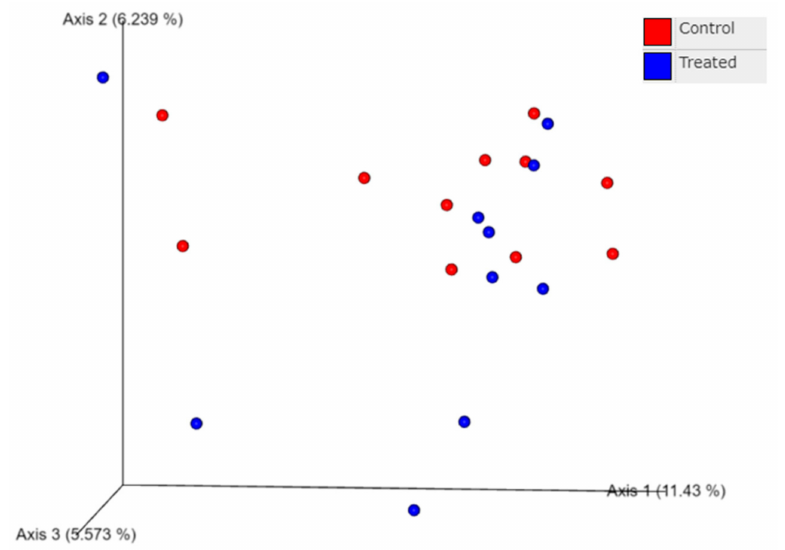
Figure 5. Principal coordinate analysis of unweighted UniFrac distances obtained from nasal swabs of calves at weaning. Data from 11 calves from CTR cows and cows supplemented with Se-yeast boluses (105 mg Se/wk), during the first (TR-1) trimester of gestation, that had WB-Se in the range of 0.06 to 0.13 ng/mL were compared with 10 calves from cows supplemented with Se yeast during the second (TR-2) and third (TR-3) trimesters of gestation that had WB-Se in the range of 0.15 to 0.21